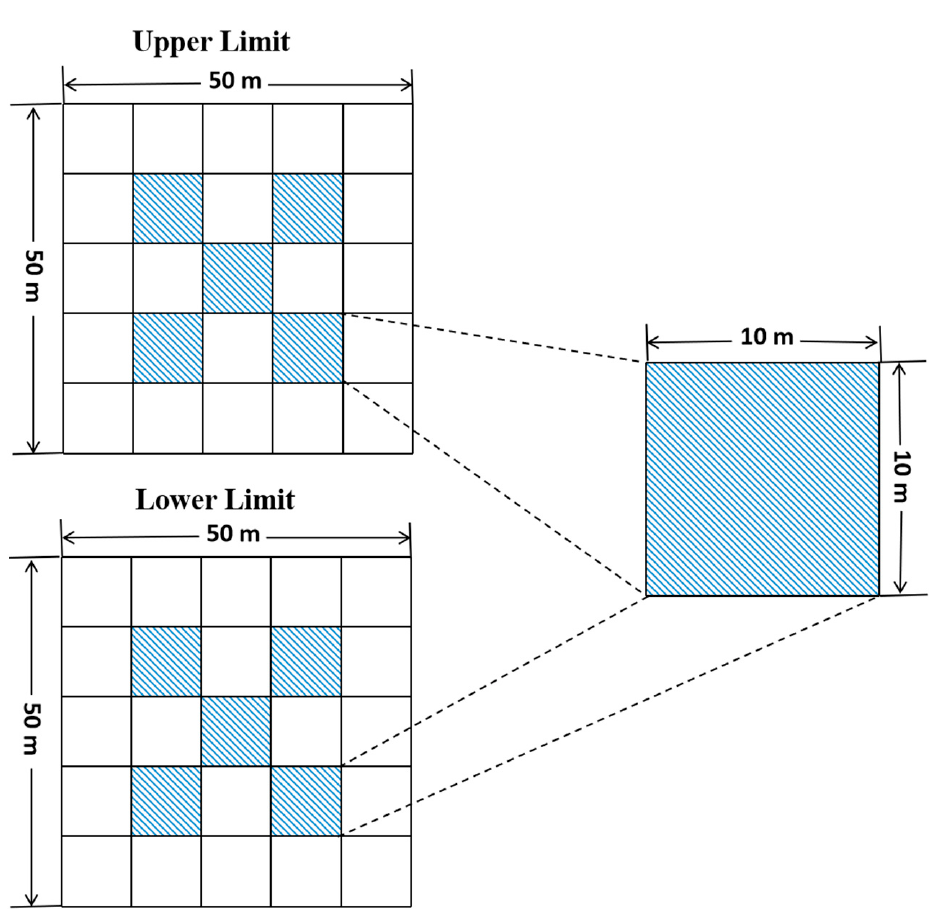
Figure 2. Sampling plot design.